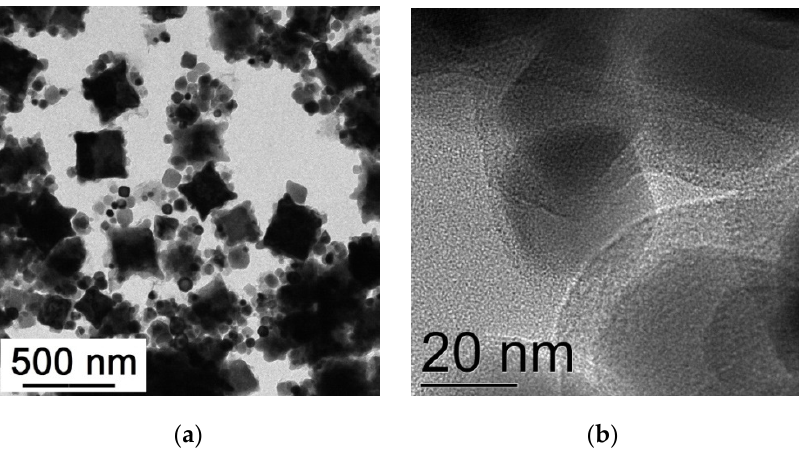
Figure 6. TEM ( a ) and HRTEM ( b ) images of the Fe 3 O 4 @C@C NPs after annealing. The sample Fe 3 O 4 @C@C morphology did not change after thermal treatment (compare